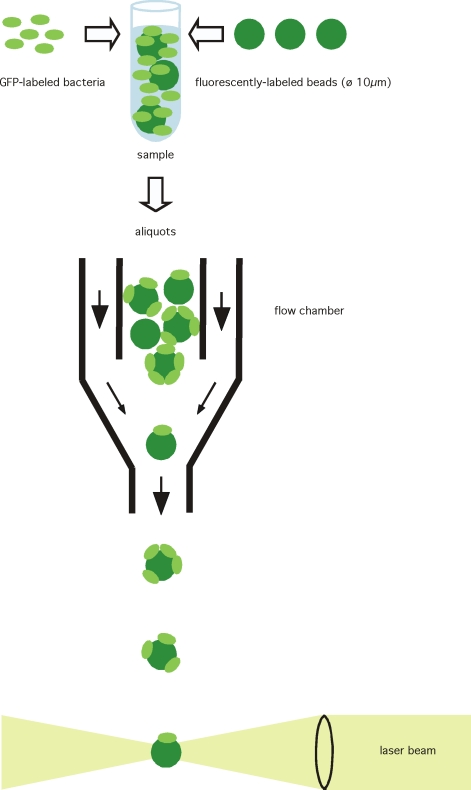
Schematic Presentation of the Micrometric Short–Time Scale Colloidal AssayGFP-labeled bacteria are mixed with fluorescently labeled particles at a ratio of 200 to one. The mixture is stirred by vortexing and first aliquots are removed within seconds for analysis by flow cytometry.